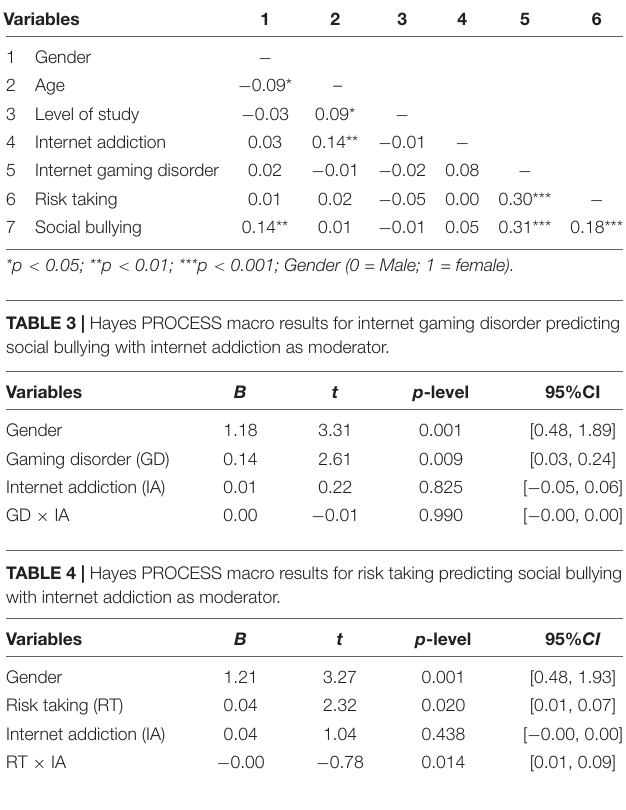
TABLE 2 | Correlations of demographic variables, internet addiction, internet gaming disorder, risk-taking, and social bullying. Variables